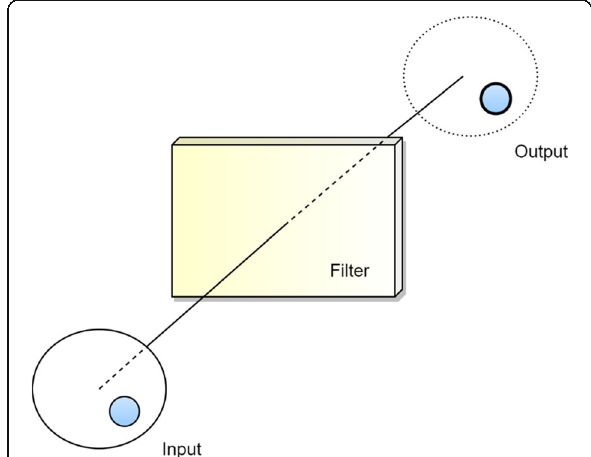
Fig. 3 Filtration of input through